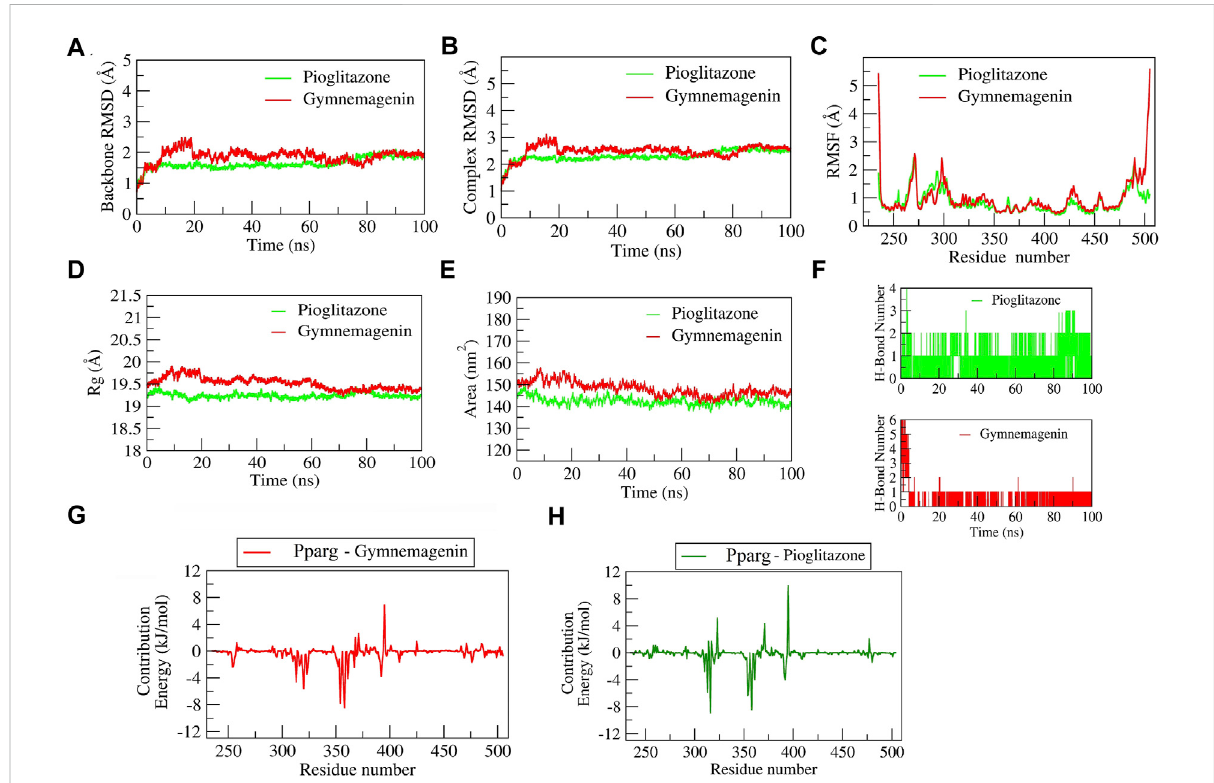
FIGURE 10 Parameters describing gymnemagenin and pioglitazone – Pparg complexstructural stabilities. (A) RMSDof backbone, (B) RMSD ofcomplex, (C) RMSF, (D) Rg, (E) SASA, (F) numberofH-bondinteractions,and (G,H) per-residuecontributionenergyplothighlightingtheimportanceofthebinding pocket residues in stable complex